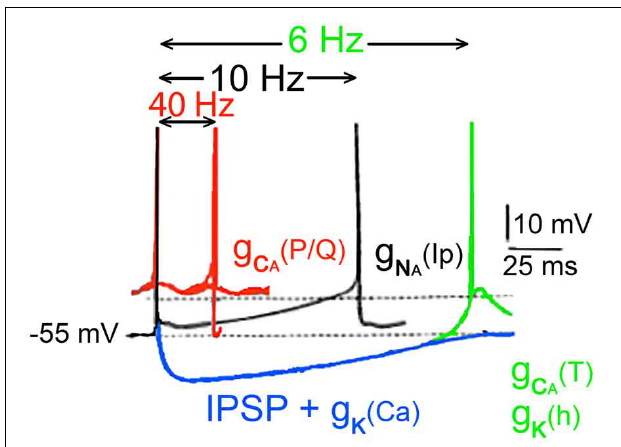
FIGURE 12 | Conducances underlying the oscillatory properties of thalamic neurons. In black, usual Na + dependent spike is followed by an after hyperpolarization generated by the classical voltage-sensitive K + conductance. Depending on membrane potential, this event can be followed by a persistent sodium current [(g Na(Ip) ) black spikes]. Following an inhibitory synaptic potential a hyperpolarization dependant deinactivation of type a g Ca(T) conductance, and the simultaneous inactivation of the potassium conductance g K(Ih) together generate a rebound response (green). The membrane potential is brought back to the threshold for the fast spike by the slow potassium conductance. In addition to the 10-Hz oscillations, slower oscillations (about 6Hz) can occur by the rebound excitation (blue trace) following hyperpolarization of the cell [g K (Ca)] and inhibitory postsynaptic potentials (IPSPs). Such hyperpolarization deinactivates the low-threshold Ca 2 + conductance generating a rebound low threshold spike, which triggers the process once again activating potassium conductance (Ih). (Jahnsen and Llinás, 1984b,c; McCormick and Prince, 1986).